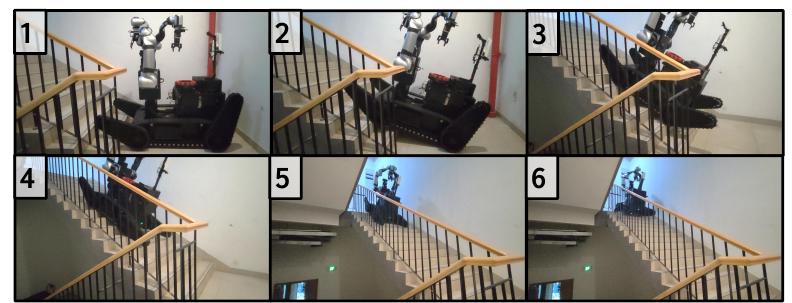
Figure 10. Stair climbing experiment (details of Steps 1–6 are explained in Supplementary Video).